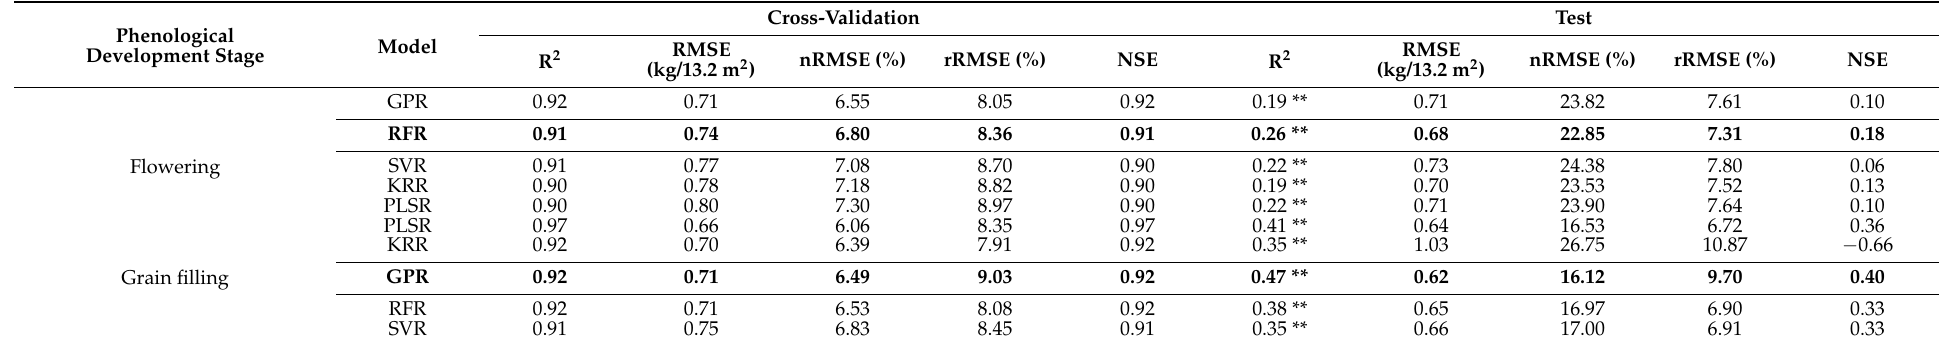
Table 10. Results of GY retrieval with nonparametric models, n_training = 164, n_test = 55. Levels of significance: ns. not significant; * p < 0.05; ** p < 0.01. The best performing models for each variable are in bold.